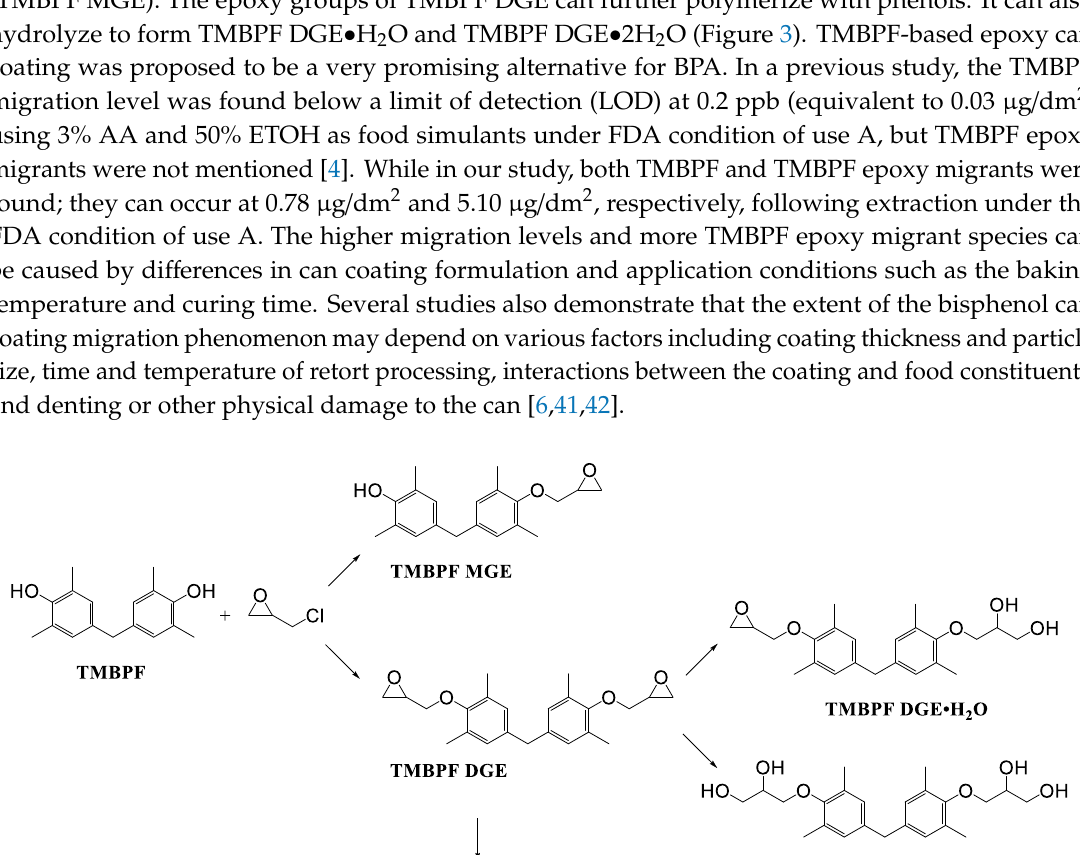
Figure 2. Isotopic pattern comparisons of molecular ions (Top) and theoretical molecular ions (Bottom). ( a ) TMBPF; ( b ) TMBPF DGE.